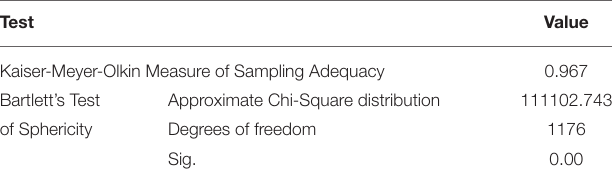
TABLE 6 | KMO and Bartlett’s sphericity test results of the